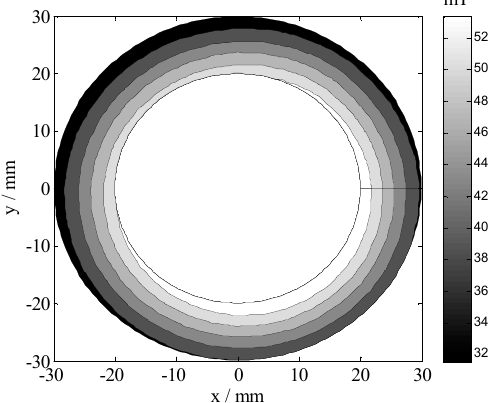
Figure 3. Magnetic field measured using a gauss meter in the ROI.